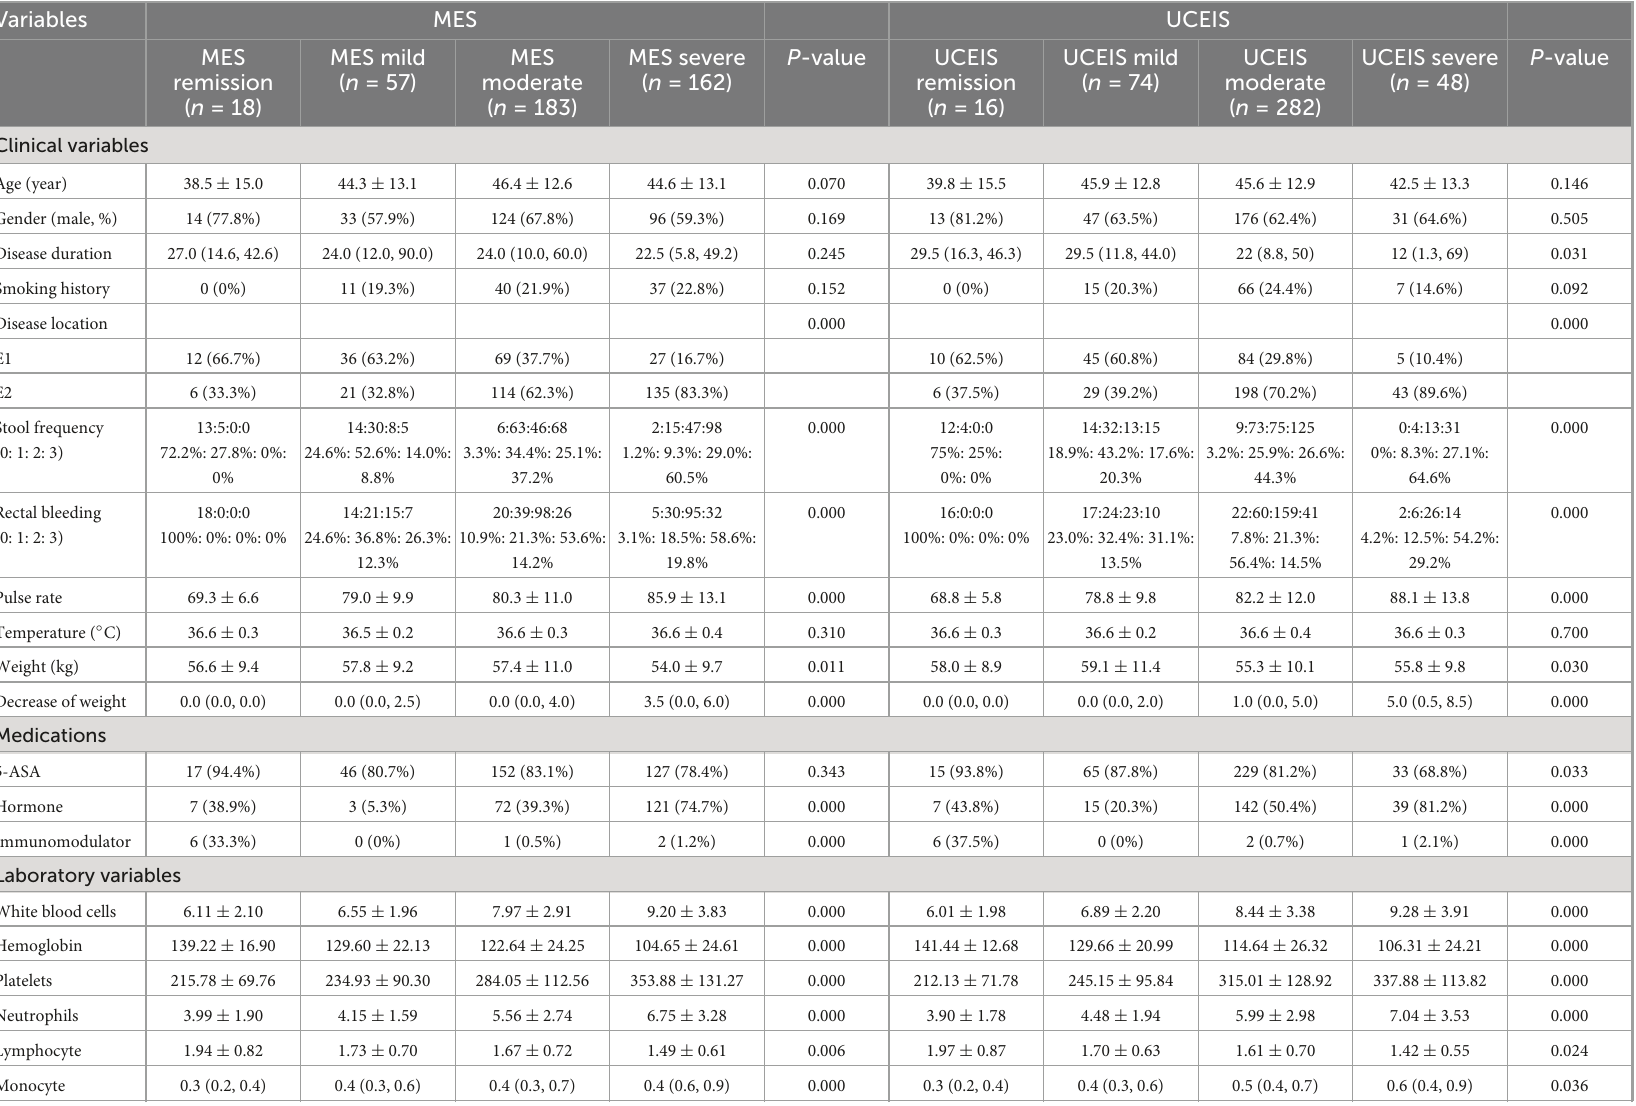
TABLE 1 Analysis of the clinical and laboratory variables in patients with ulcerative colitis.